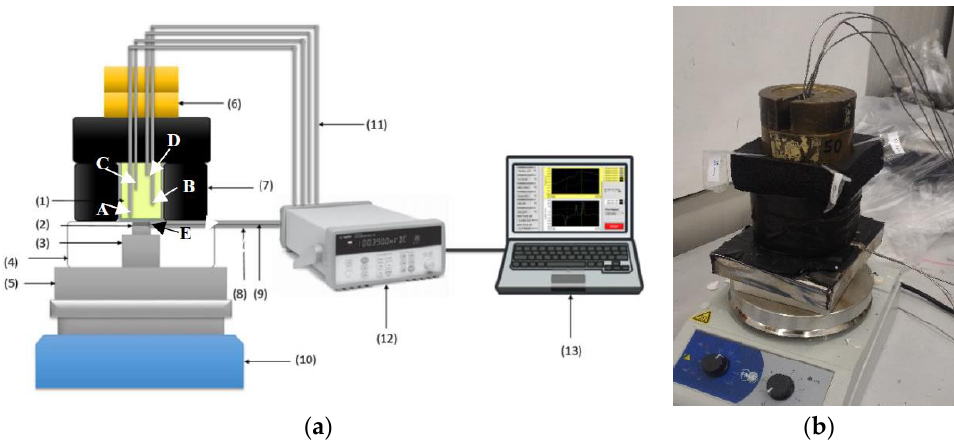
Figure 7. ( a ) Simplified representation of the “experimental set-up n. 4”: ( 1 ) Sample, ( 2 ) heat flux sensor, ( 3 ) Al cylinder, ( 4 ) base insulator, ( 5 ) Al plaque, ( 6 ) weight pans, (7 ) lateral insulator, ( 8 ) heat flux sensor’s cable, ( 9 ) K-type thermocouples at point E, ( 10 ) electrical hot-plate, ( 11 ) N-type thermocouples at points A–D, ( 12 ) mustimeter, ( 13 ) PC for data acquisition. ( b ) Picture of the experimental setup.